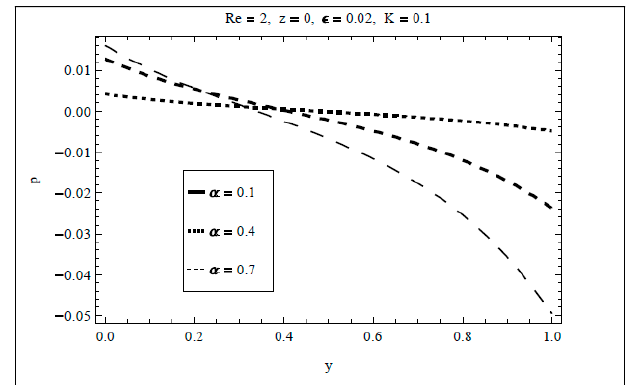
Figure 15. Effect of α on pressure p along y .